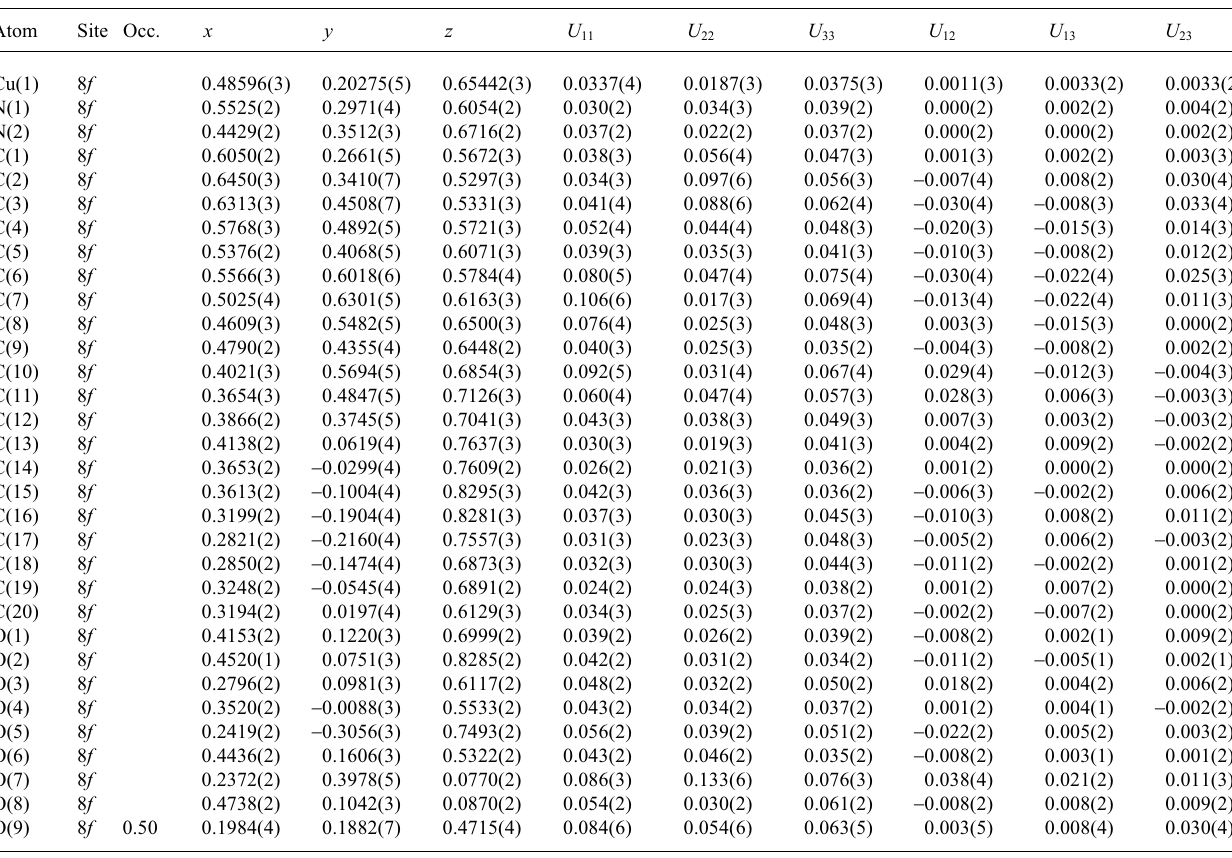
Table 3. Atomic coordinates and displacement parameters (in Å 2 ).